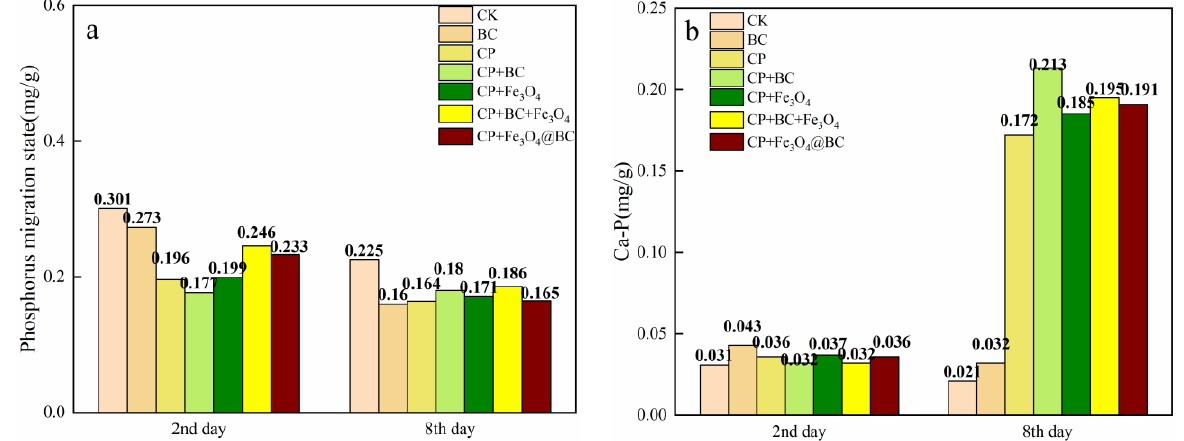
Figure 10. ( a ) The Phosphorus migration state changes on the 2nd day and the 8th day; ( b ) The Ca-P changes on 2nd day and 8th day.